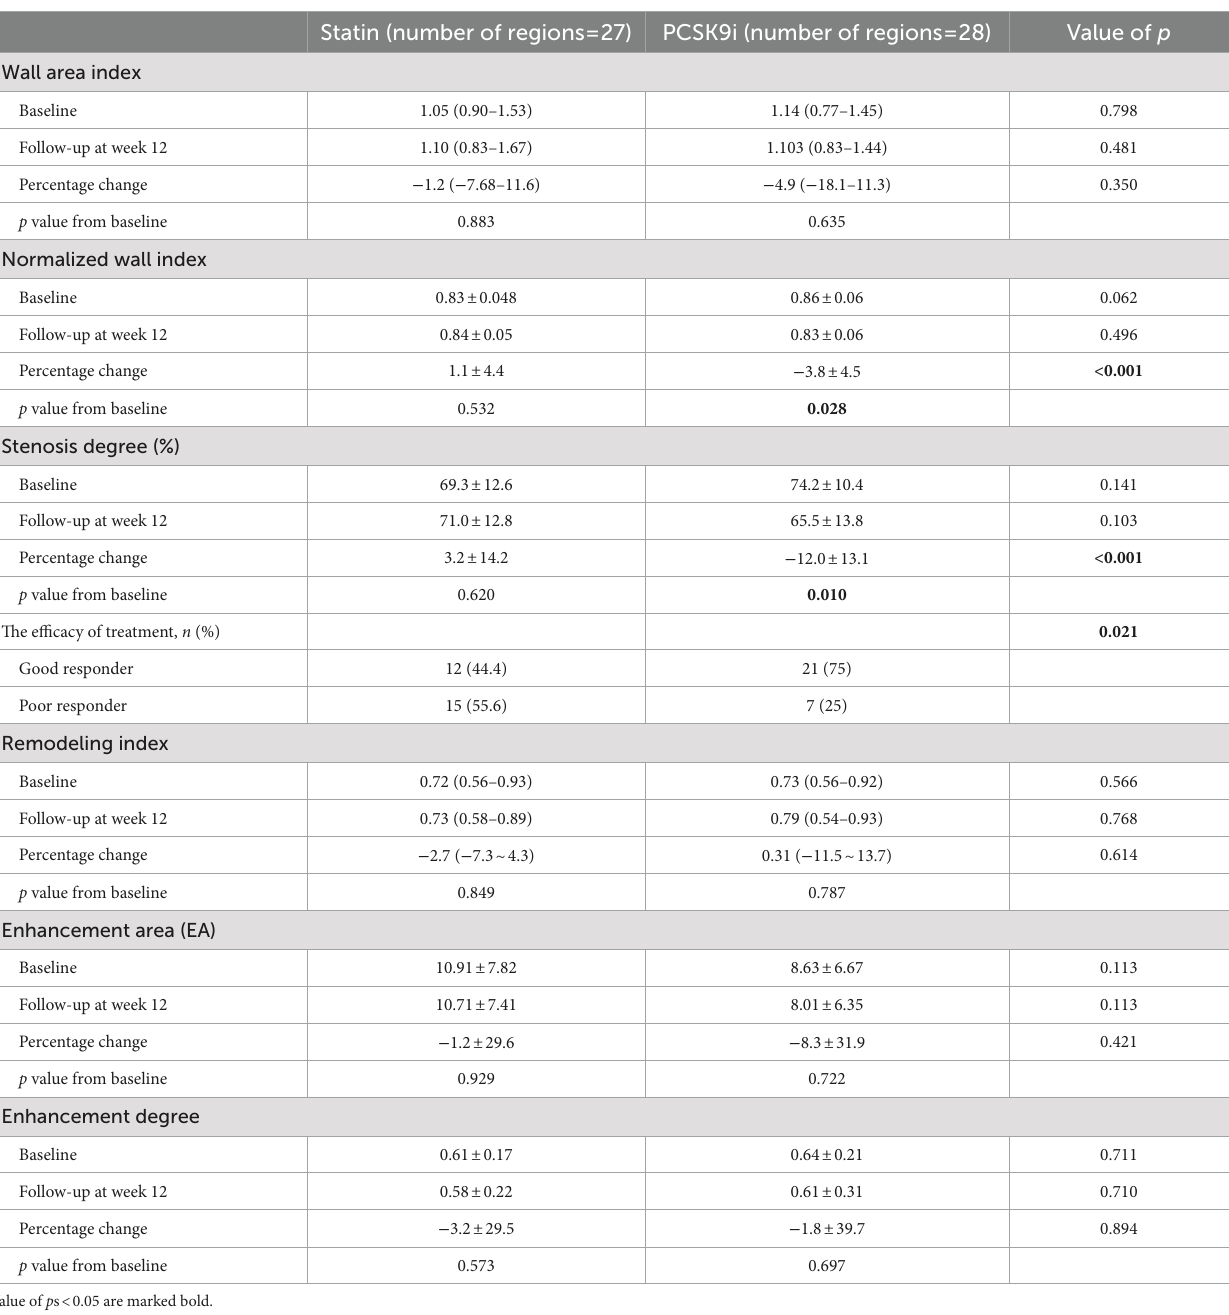
TABLE 3 HR-MRI changes.